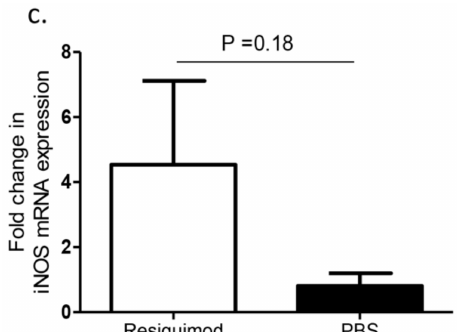
Figure 2. IFN- γ , IL-1 β , and iNOS mRNA expression levels following in ovo delivery of resiquimod or PBS. ED18 SPF eggs were treated with resiquimod (n = 6, 400 µ g of resiquimod in 200 µ L of PBS per egg) or PBS (n = 6, 200 µ L of PBS per egg) and incubated to hatch. On the day of hatch, birds were euthanized, and lung tissues collected to assess mRNA expressions of ( a ) IFN- γ , ( b ) IL-1 β , and ( c ) iNOS. One-tailed Student’s t-test was performed to identify group differences. The differences were considered significant at p ≤ 0.05. The error bars represent ± SEM.